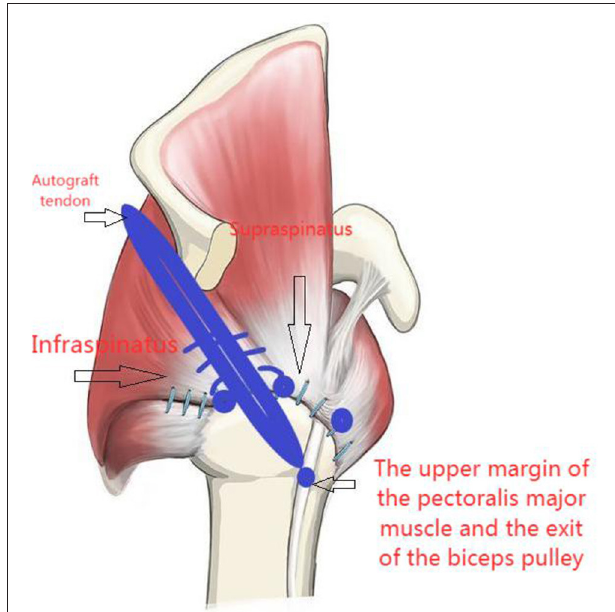
FIGURE 8 | Surgery diagram.